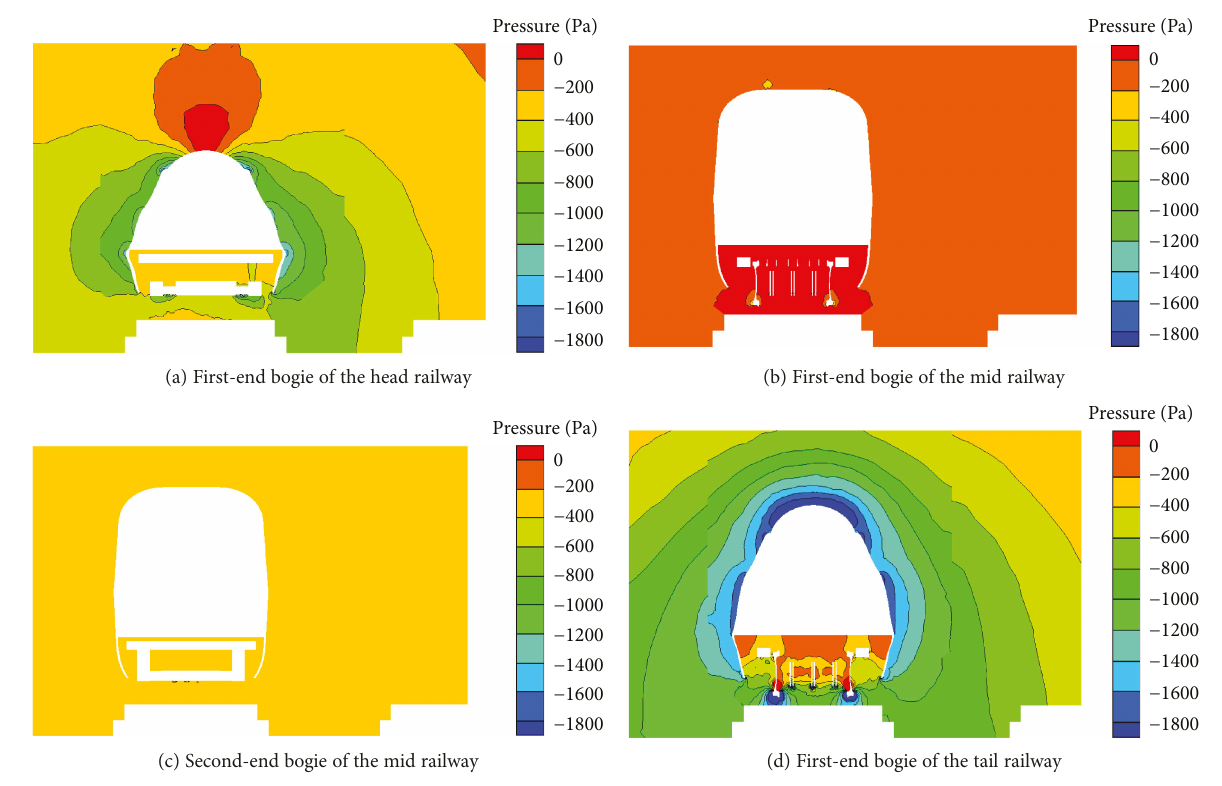
Figure 5: Contours of pressures on di ff erent cross sections of high-speed railways.